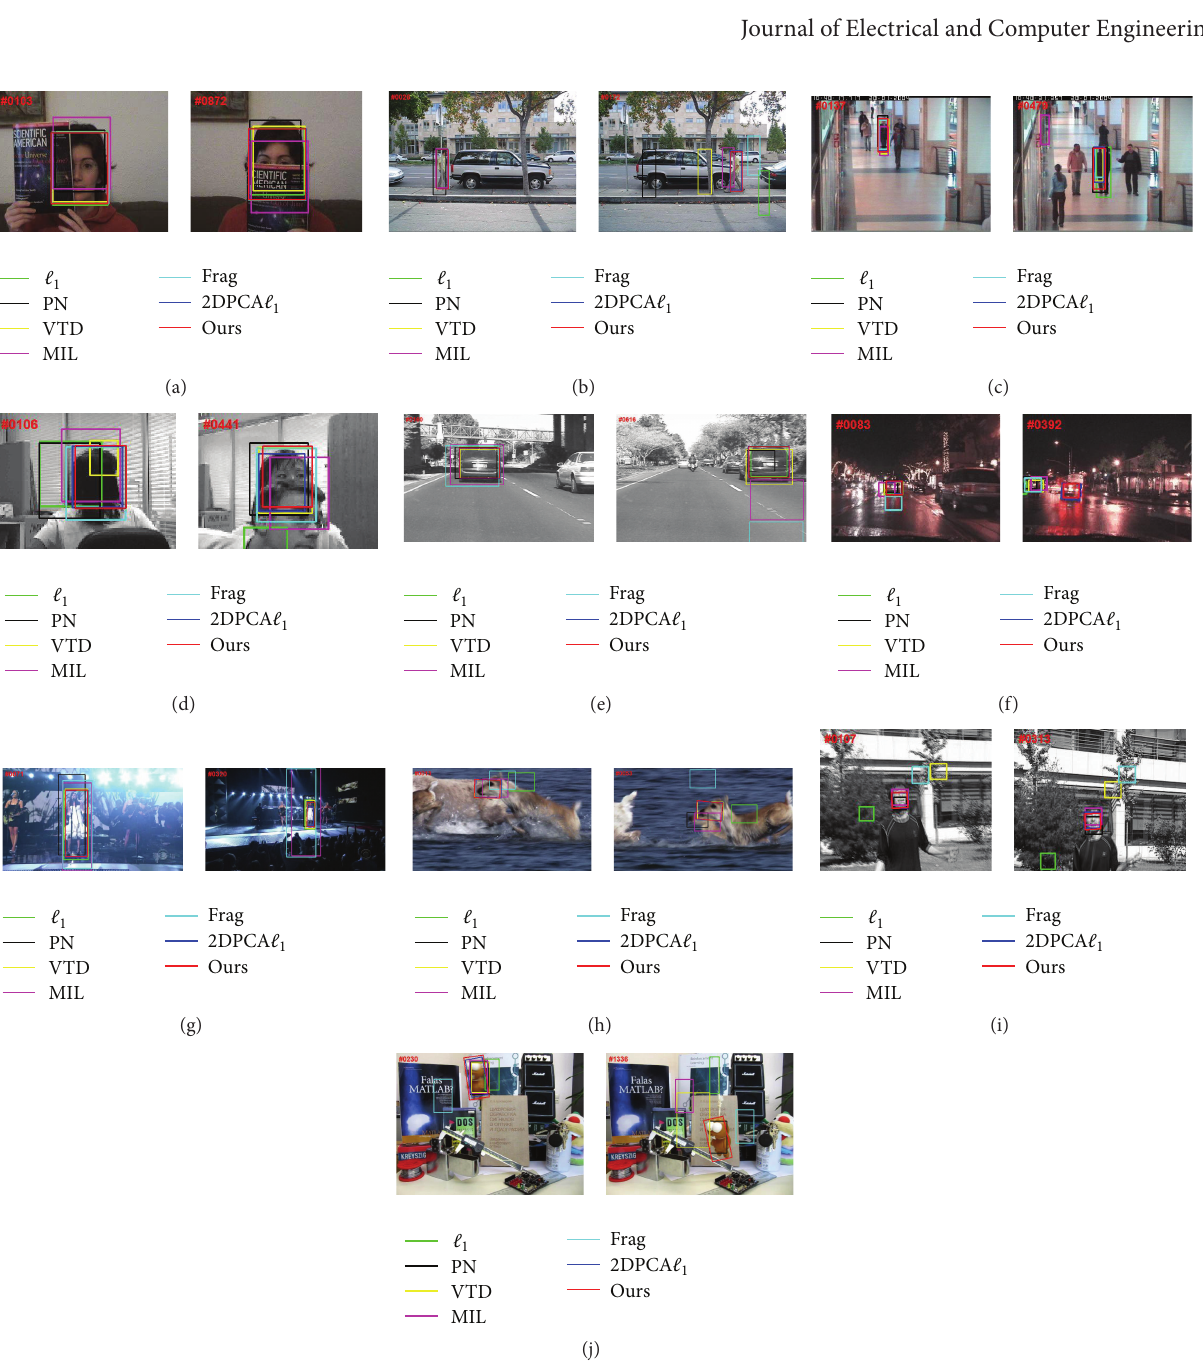
Figure 1: Sampled tracking results of partial evaluated algorithms on ten challenging